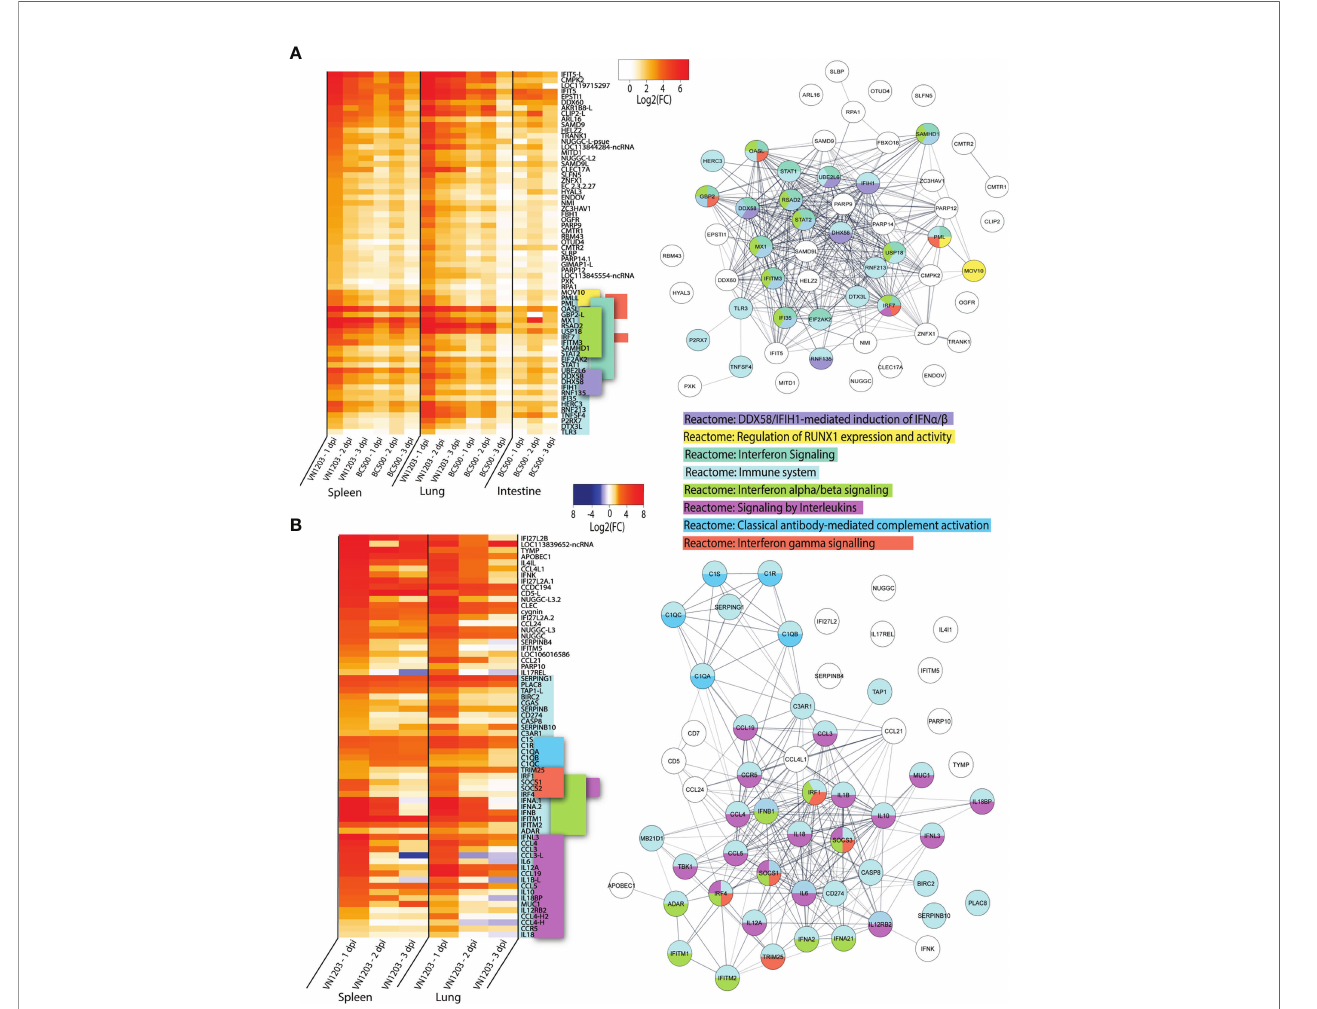
FIGURE 4 | VN1203 and BC500 upregulate genes shared between all tissues sampled. Lists of statistically signi fi cant (FDR<0.05) genes were compared for similarity in expression (Log2(FC)>1) and clustered together if they were expressed in (A) all tissues in VN1203 and BC500 infected ducks or (B) spleens and lungs of VN1203 infected ducks. STRING diagrams depict predicted protein-protein interactions between the products of each gene, while colour coding is based on term enrichment of Reactome pathways. No colour means that the genes did not enrich any of the Reactome terms. Reactome terms were considered signi fi cant if FDR<0.05. Enrichment and STRING diagram was created using the STRINGTIE app in